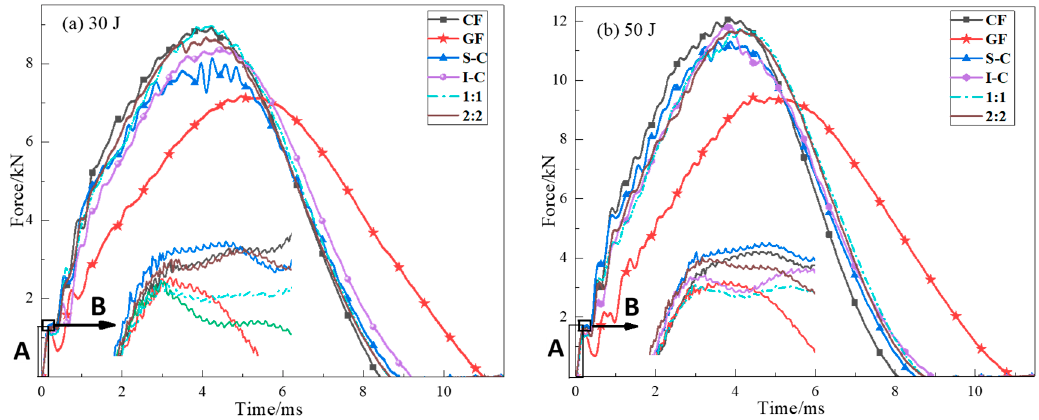
Figure 3. Force vs. time response of composite specimens at ( a ) 30 J and ( b ) 50 J.